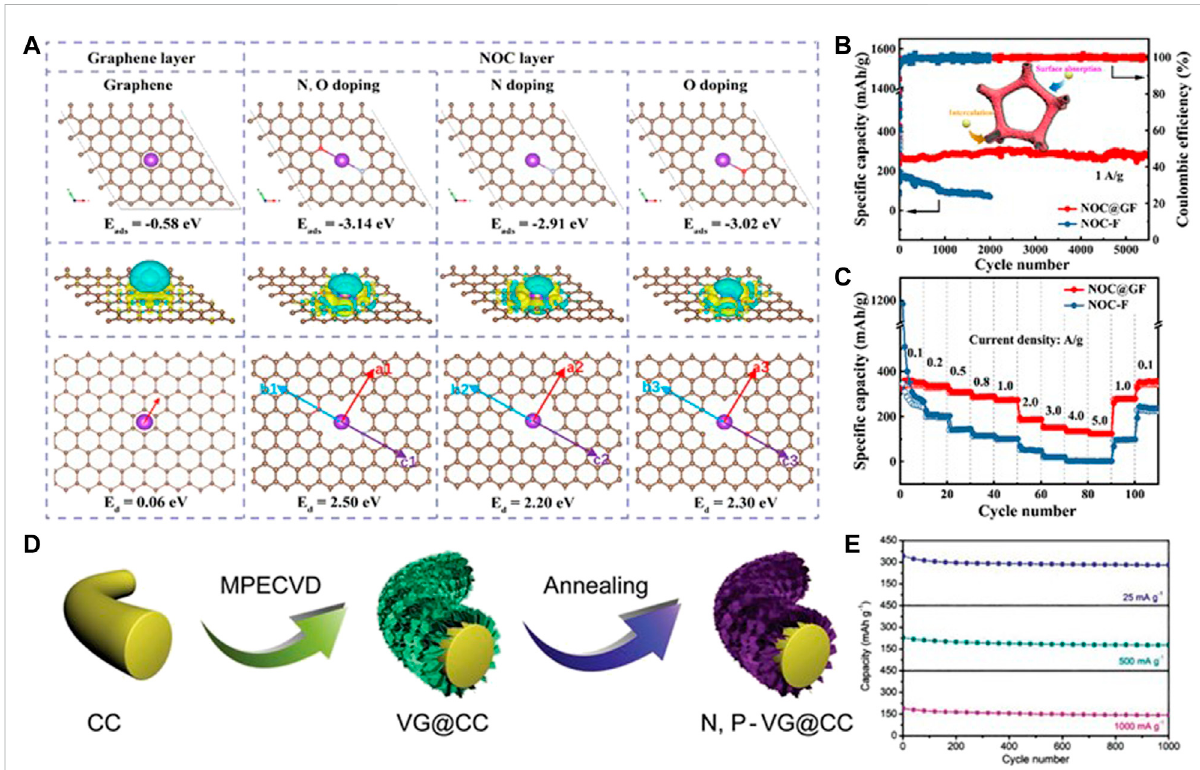
FIGURE 3 (A) Theoretical simulations of K-atom adsorption and diffusion. (B) Cycling performances at 1 A g − 1 and (C) rate performances at the current densities from 0.1 to 5 A g − 1 for NOC@GF and the NOC-F anode. Reproduced with permission (Zeng et al., 2020). Copyright 2021 Elsevier Ltd. (D) Preparation diagram and (E) cycling performances at various current densities for the N, P-VG@CC anode. Reproduced with permission (Qiu et al., 2019). Copyright 2019